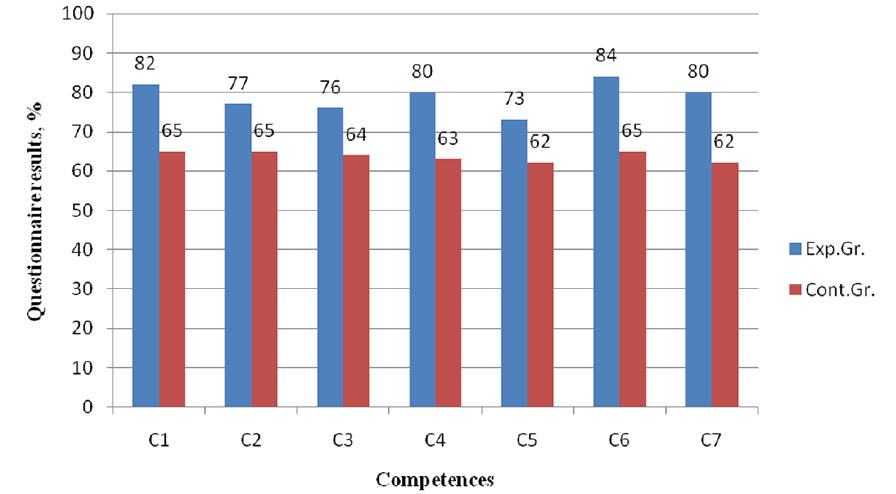
Fig. 1. Results of the questionnaire showing the competence acquisition level